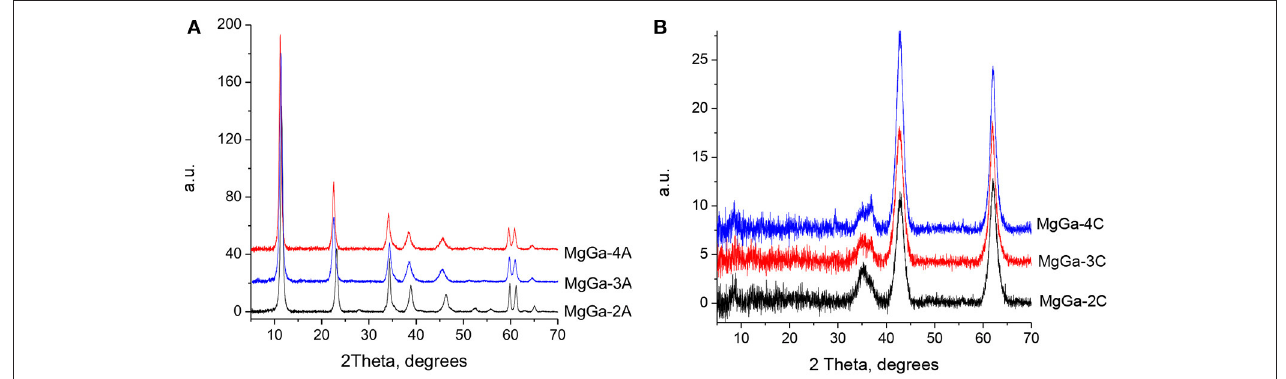
FIGURE 1 | XRD patterns of as-prepared MgGa LDHs (A) and mixed oxides (B) .